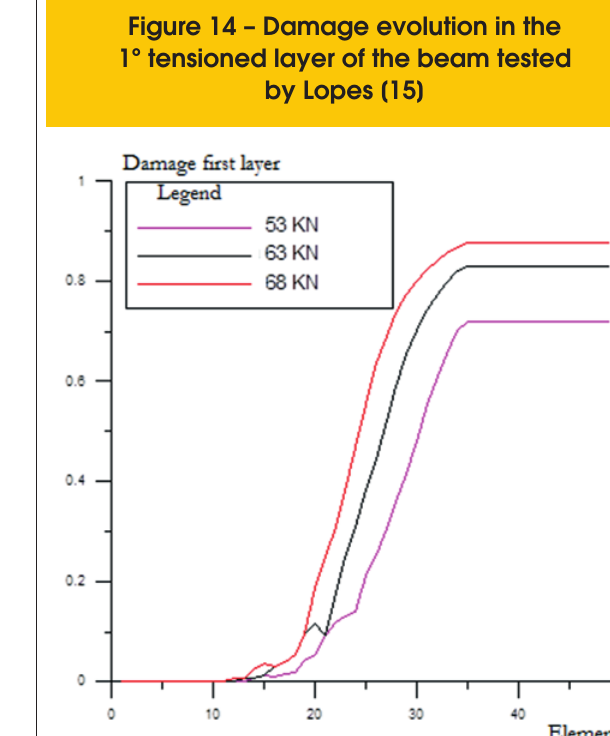
Figure 14 – Damage evolution in the 1º tensioned layer of the beam tested by Lopes